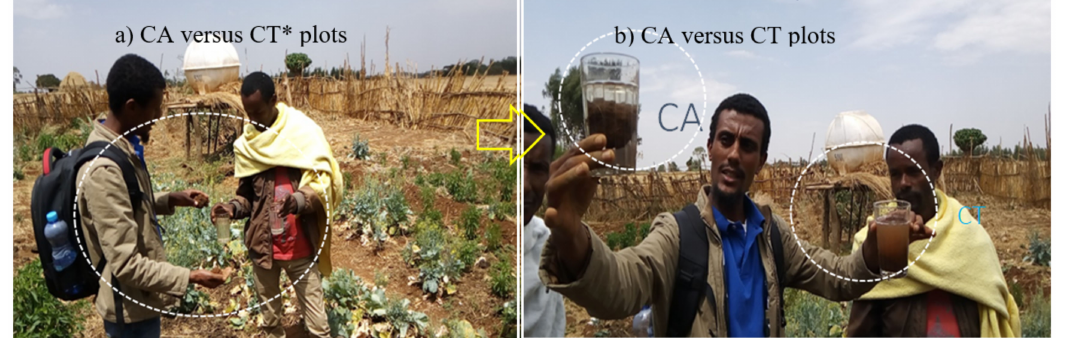
Figure 6. The effect of CA practice on soil organic matter. Farmers in Dengeshita discussing the CA impact on the rate of soil dispersion when a clog from both treatments was immersed at the same time